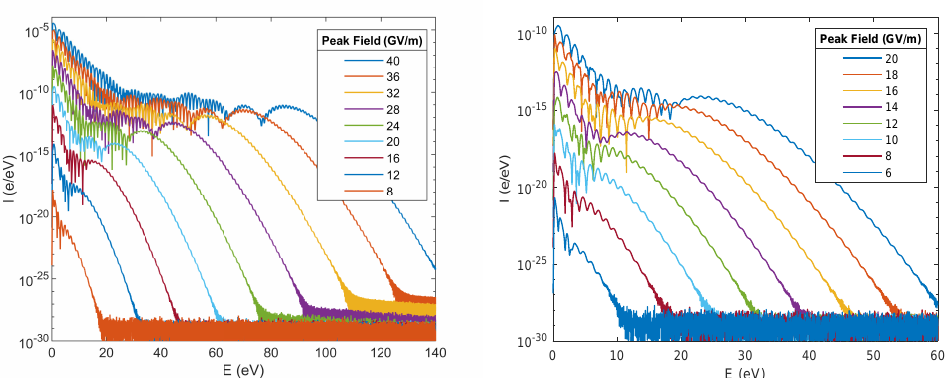
Figure 7. Comparison of spectra among all peak fields simulated ( Left ) and among mid to low fields ( Right ). These simulations use the standard potential with 800 nm incident laser pulse, no field penetration.